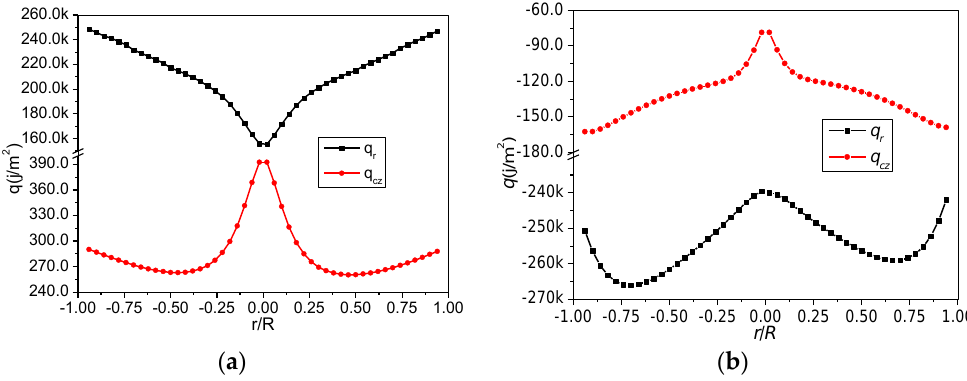
Figure 7. Radiation and conduction heat flux on surfaces of SiC powder and crystal. ( a ) SiC powder surface; ( b ) SiC crystal surface.